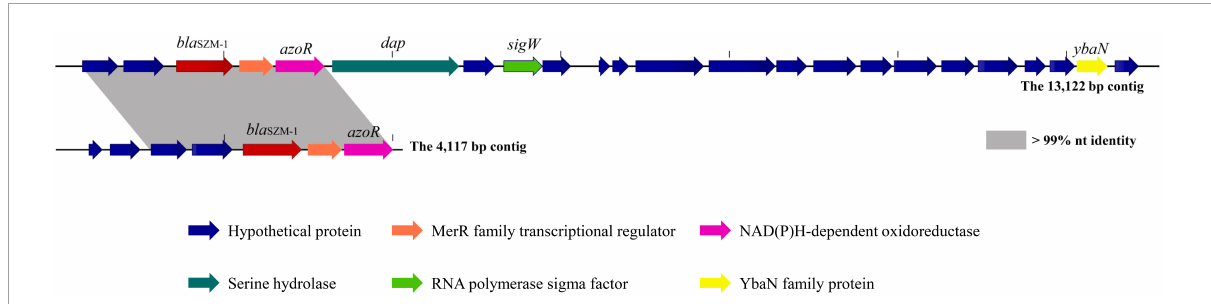
FIGURE1 Genetic context surrounding the bla SZM − 1 gene. The genetic contexts of bla SZM − 1 on the 13,122-bp contig and the 4,117-bp contig are shown for comparison. The orfs that encode hypothetical proteins with unknown functions are shown in blue. Regions of > 99% homology are marked with gray shading. The arrows indicate the positions and directions of transcription for each gene.